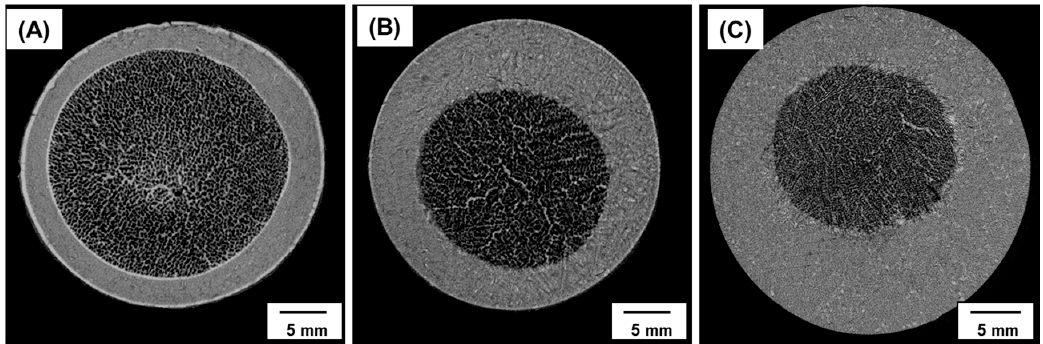
Figure 8. Micro-CT images of porous HA scaffolds with bone-like structures: ( A ) S den / S por = 0.44; ( B ) S den / S por = 1.25; and ( C ) S den / S por = 3 ( Sden -surface area of dense region; Spor -surface area of porous region).